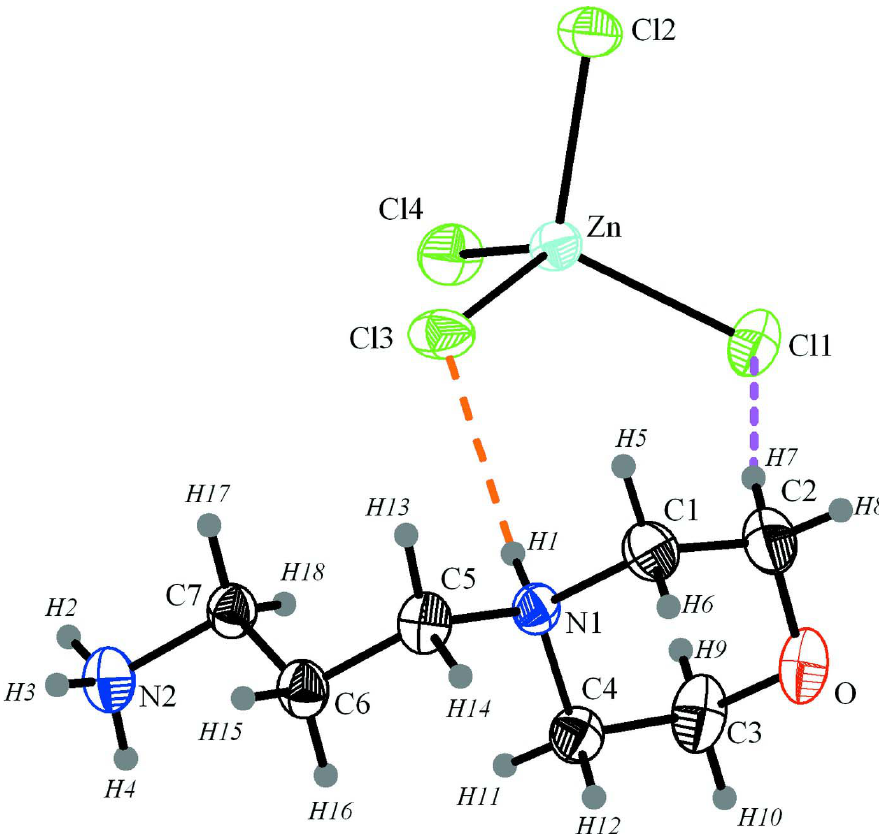
Figure 1 The molecular structure of the title compound, showing displacement ellipsoids drawn at the 40% probability